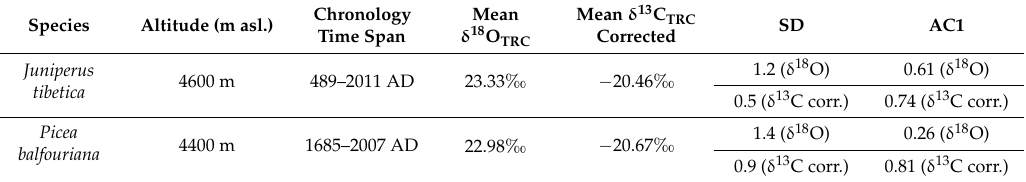
Table 1 . General site information and chronology statistics for the common period 1685–2007. Table 1. General site information and chronology statistics for the common period